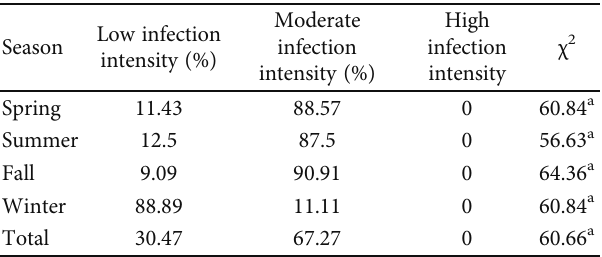
Figure 11: Ostertagia : head square, sheath tail forms a medium cone, and length 825 – 926 μ m. Third-stage Table 2: Comparison of the average percentage of sheep infected at di ff erent seasons of the year.